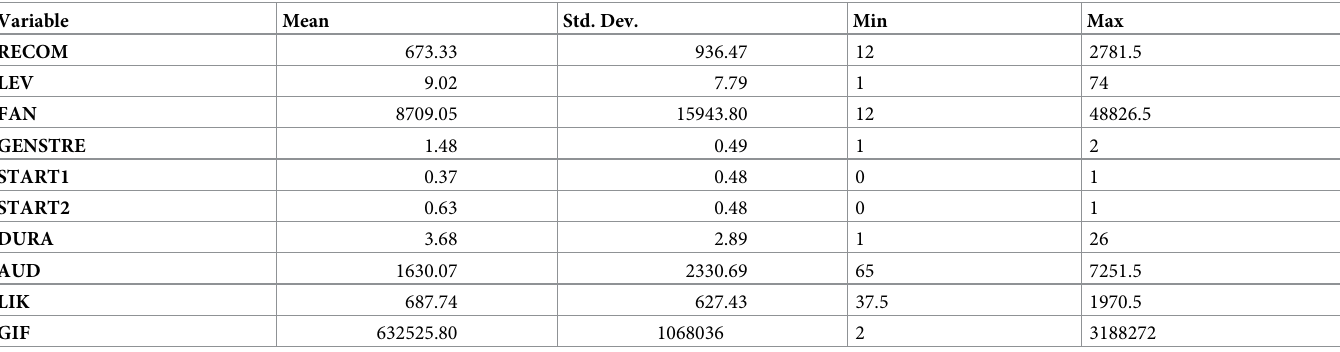
Table 2. Descriptive statistics of the original variables (N =